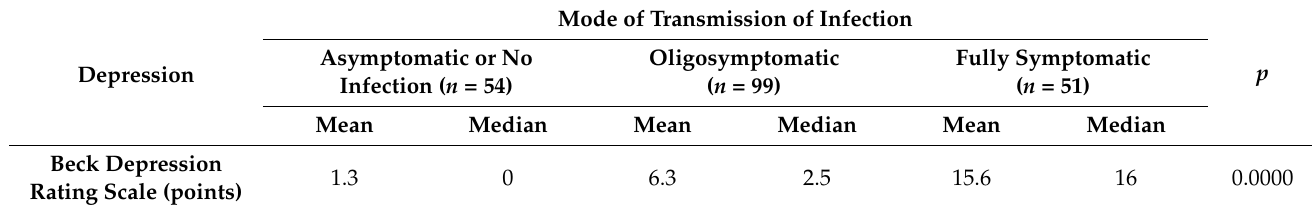
Table 7. Course of infection and depression.